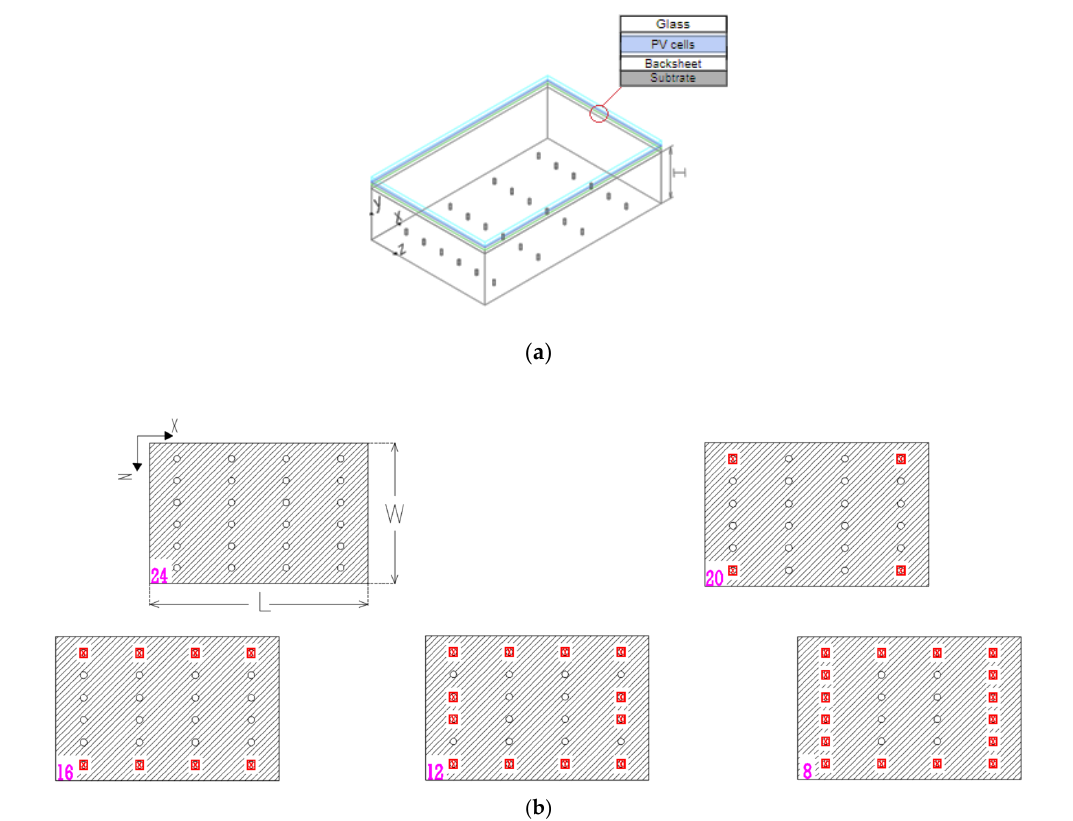
Figure 1. Configuration of the PV/JIC system. ( a ) Schematic diagram and ( b ) nozzle arrays. Table 1. Design parameters and thermophysical properties of PV components [4, 14]. Table 2 gives the thermophysical properties of NECPM particles and water [20]. The . melting process of PCM in particles occurs at a span temperature between 21 ◦ C and 29.5 ◦ C, and the melting point is assumed 25.25 ◦ C [20]. The diameter of particles equals 100 nm. The variation range of important parameters in this study is given in Table 3. Table 2. Thermophysical properties of water and NEPCM [20].